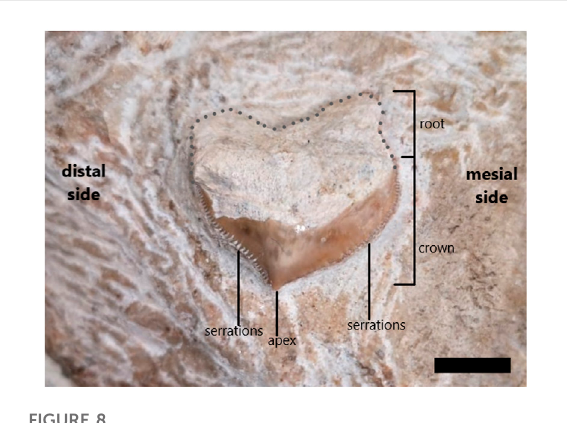
FIGURE 8 Squalicorax pristodontus tooth (from CPG/1/12,265) found